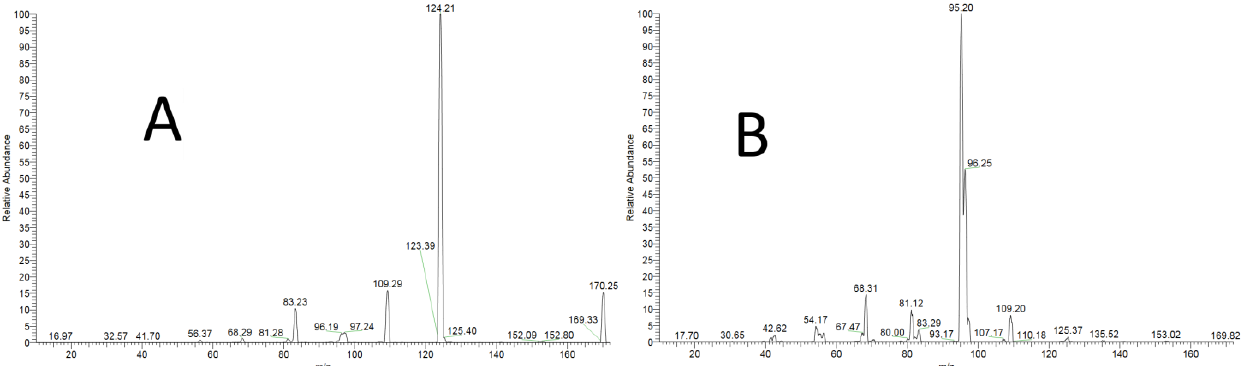
Figure 2. ( A ): Mass spectrum at a CE of 15 V for τ -MH. The spectrum is an average of 50 scans, from 10 to 172 m/z for the precursor 170 m/z . Ion 124 is the most intense peak in the spectrum, ( B ): Mass spectrum at a CE of 30 V for π -MH. The spectrum corresponds to the average of 50 scans, from 10 to 172 m/z for the precursor 170 m/z . Ion 95 is the most intense peak in the spectrum. Readers should refer to Figure S4 for more details.